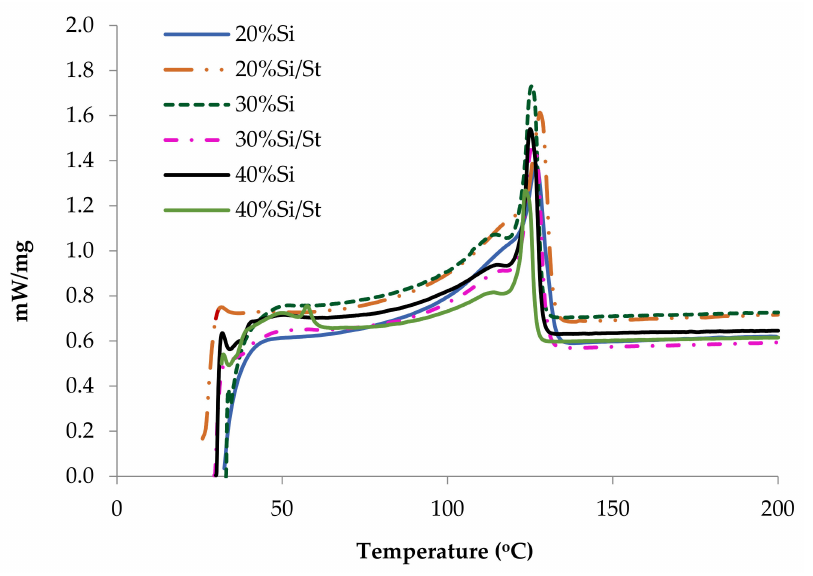
Figure 5. The DSC curve of the silica/PE